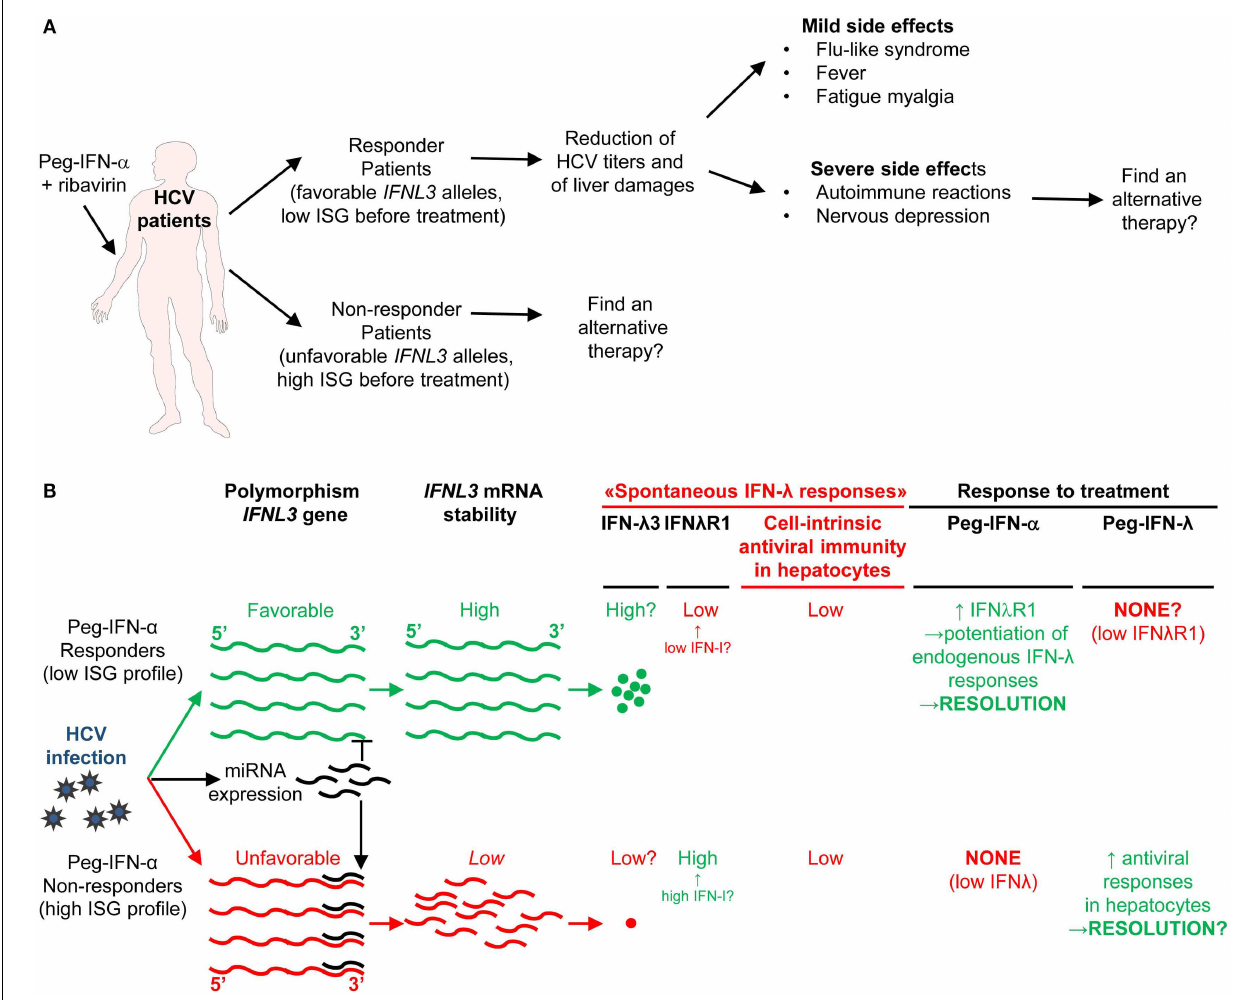
FIGURE 7 |A novel hypothetical model attempting to explain the respective roles of IFN-I and IFN-III in HCV infection . (A) Classification of patients suffering from chronic HCV infection and treated with PEG-IFN- α in non-responders and responders, and identification of IFNL3 ( IL28B ) gene polymorphisms as the best predictors for treatment response.The side-effects induced by PEG-IFN- α treatment are also listed since they can severely affect the patient’s quality of life and lead to treatment failure due lack of compliance or suicide. Hence, new approaches are needed to promote beneficial over deleterious effects of IFN-I administration in chronic HCV infection. (B) Proposal of a new hypothesis explaining the relationships between endogenous ISG levels in patients prior to treatment, IFNL3 gene polymorphism, endogenous expression of IFN-I, IFN- λ , and IFN λ R1, and responsiveness to IFN-I administration. Efficient control of HCV infection may depend on hepatocyte response to IFN- λ rather than IFN- α . Upon HCV infection, the virus induces the expression of host miRNA able to bind the 3 (cid:48)